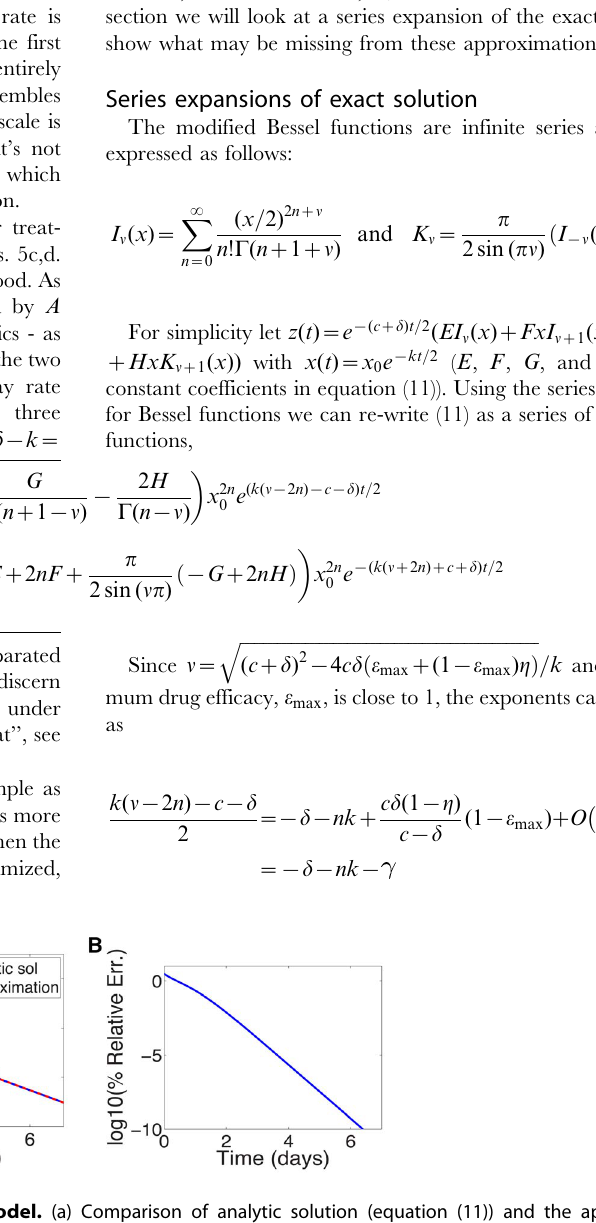
PLOS Computational Biology |